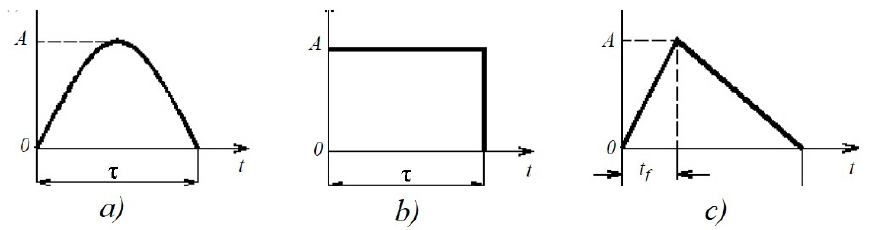
Figure 8. Shock pulse shapes: ( a ) semi-sinusoidal; ( b ) rectangular; ( c )